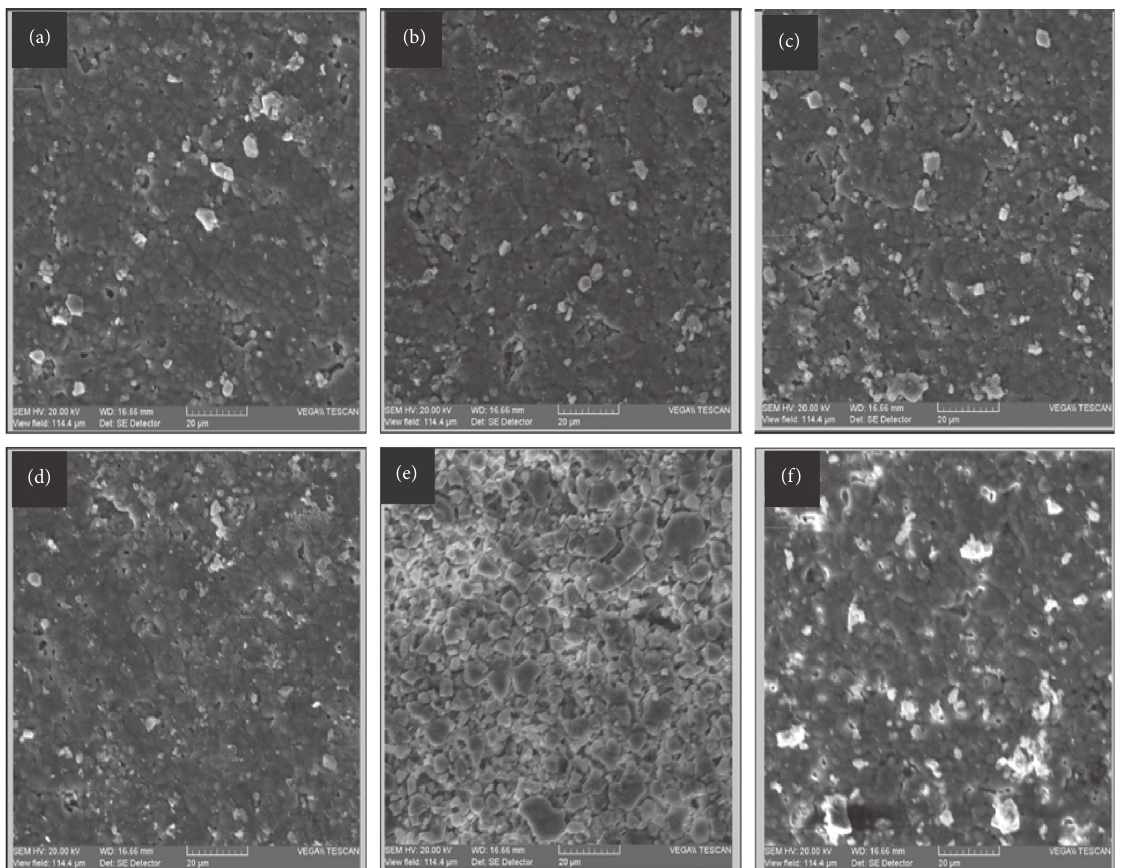
Figure 2: SEM micrographs of hydroxyapatite discs treated with phosvitin. Hydroxyapatite discs were damaged in the acid damage immersion assay in the presence of varying concentrations of phosvitin. Surface morphology was imaged with SEM at a working distance of 16.66mm. (a) 1 mg/mL phosvitin. (b) 0.5 mg/mL phosvitin. (c) 0.25mg/mL phosvitin. (d) 0.12mg/mL phosvitin. (e) No phosvitin. (f) A hydroxyapatite disc not subjected to the acid damage immersion assay. The view field for each acquisition was 144.4 μ m